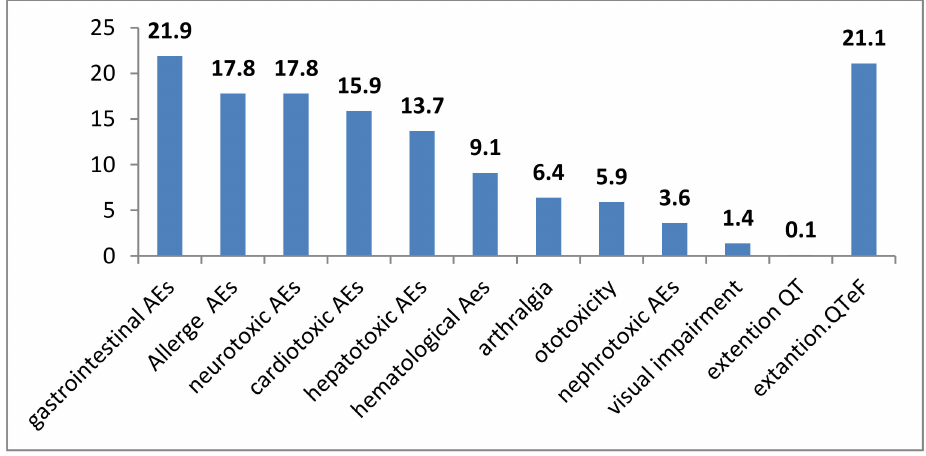
Figure 6. The spectrum of adverse events during therapy with bedaquiline (%). (AEs—adverse events).